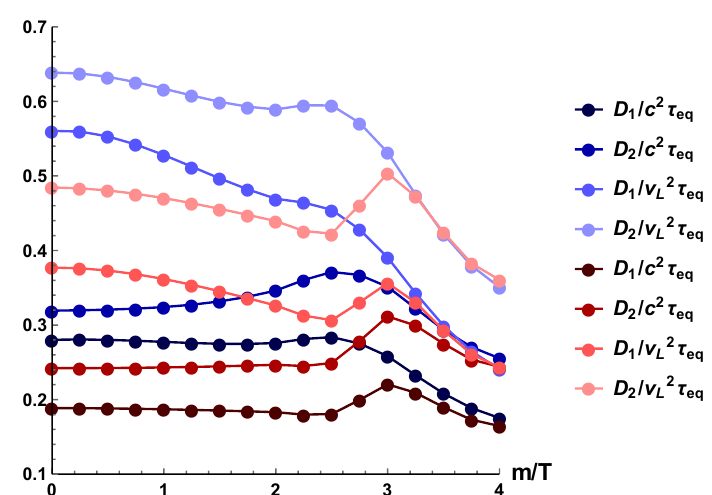
Figure 8: A verification of the universal upper bound (50) imposed by causality. The blue points are for µ/ T = 3 while the red for µ/ T =